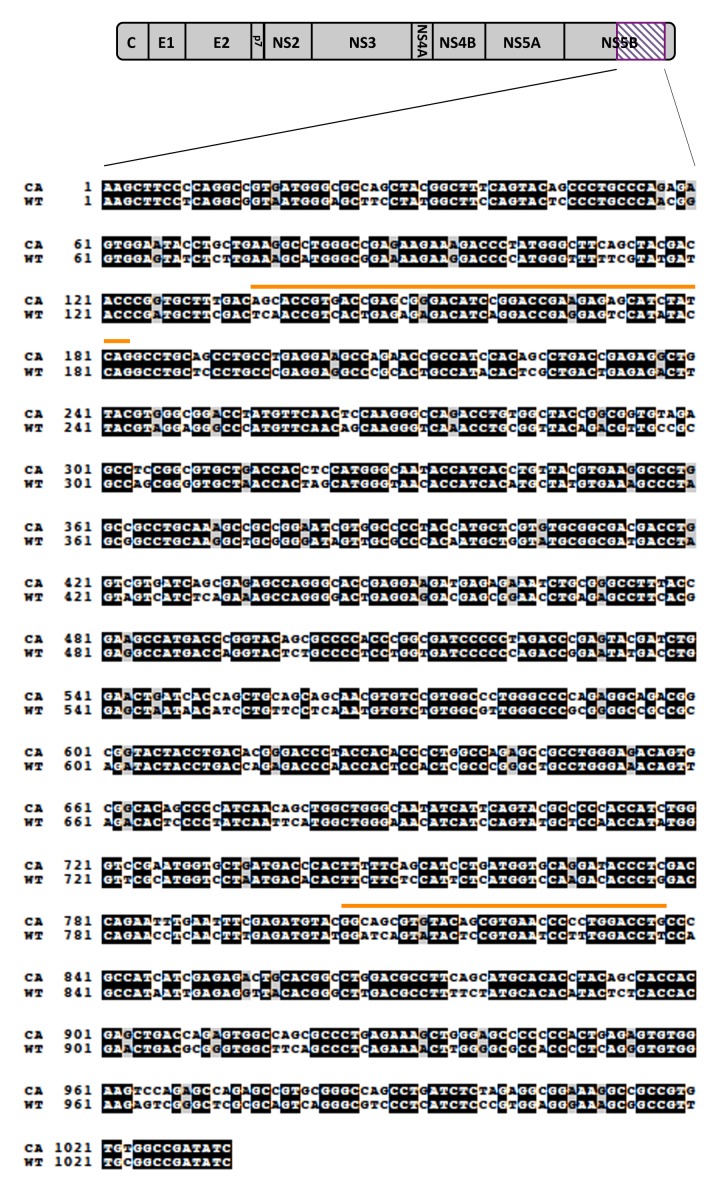
Alignment of codon-altered and wild-type JFH1 viral RNAs.Sequence alignments were generated using ClustalW to highlight the nucleotide changes incorporated into the CA-1 viral RNA. Sequences highlighted with orange bars identify regions containing covarying mutations indicating functional RNA secondary structures.